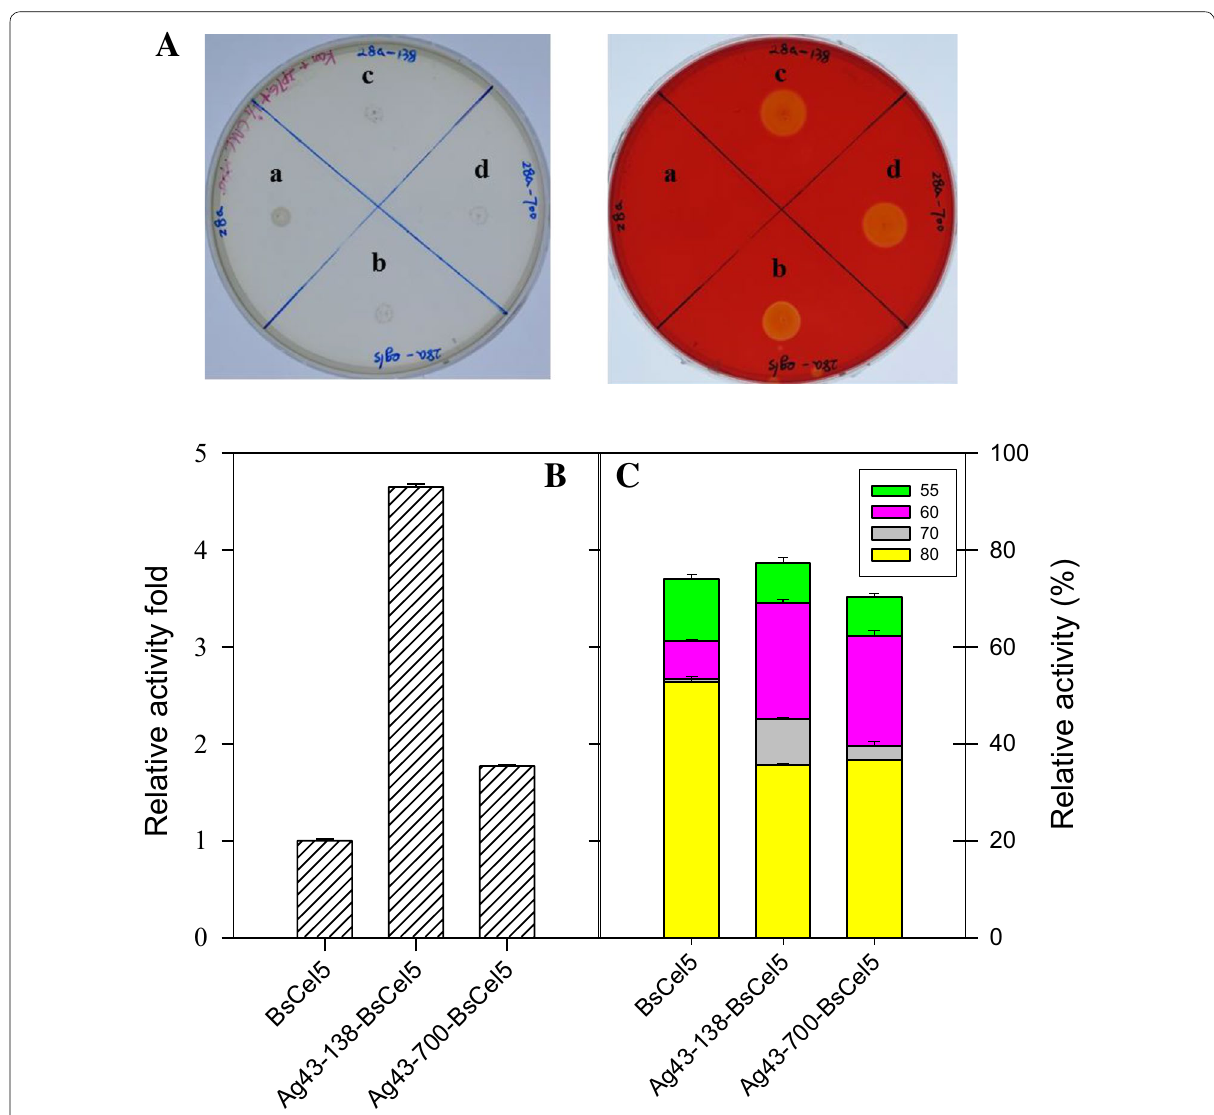
Fig. 6 The performance of cell surface display for BsCel5. A Congo red tests for cells harboring plasmids pET28a (a), pET28a‑BsCel5 (b), pET28a‑Ag43‑138‑BsCel5 (c), and pET28a‑Ag43‑700‑BsCel5 (d). Left and right images represent before and after congo red staining, respectively. B Whole‑cell activity assay for cells harboring pET28a‑BsCel5, pET28a‑Ag43‑138‑BsCel5, and pET28a‑Ag43‑700‑BsCel5. The activity was measured by the amount of unit possessed per milliliter culture (OD 600 nm of 2). One unit of activity was defined as the amount of glucose generated per minute. The activity of pET28a‑BsCel5 was 0.27 U/mL and defined as 1. C Thermal stability of BsCel5 in the different recombinants. The activities of BsCel5 at 55, 60, 70, and 80 °C are indicated with stacked bars in green, pink, gray, and yellow (from top to down),